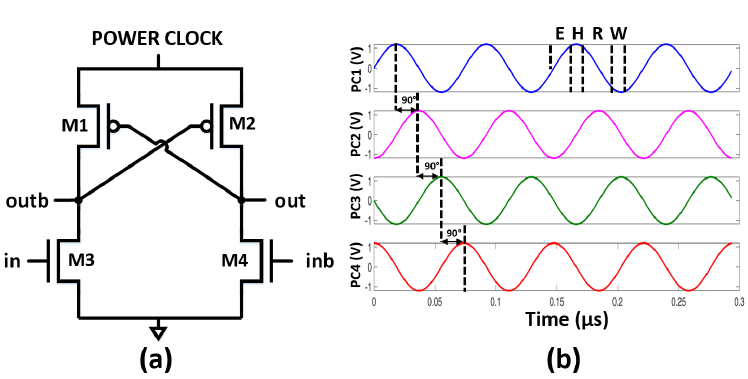
Figure 1. Operation of an ECRL buffer: ( a ) transistor-level schematic, ( b ) four-phase sinusoidal power-clock inputs, each with a 90 ◦ phase